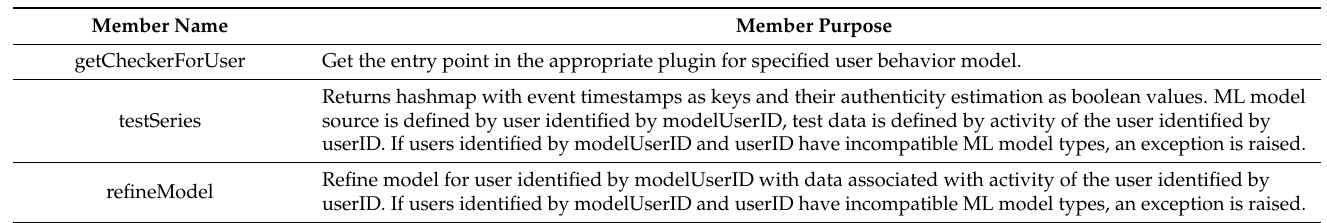
Table A8. Members of UserActivityTester class.